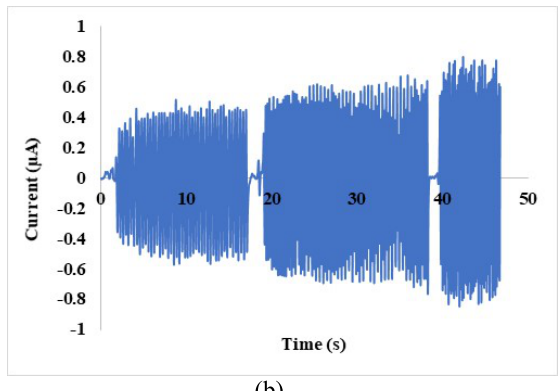
Figure 7. The output current of the spiral electrode device when the sliding motions with three different frequencies are applied on a) 8-turns and b) 16-turns spiral electrode devices.